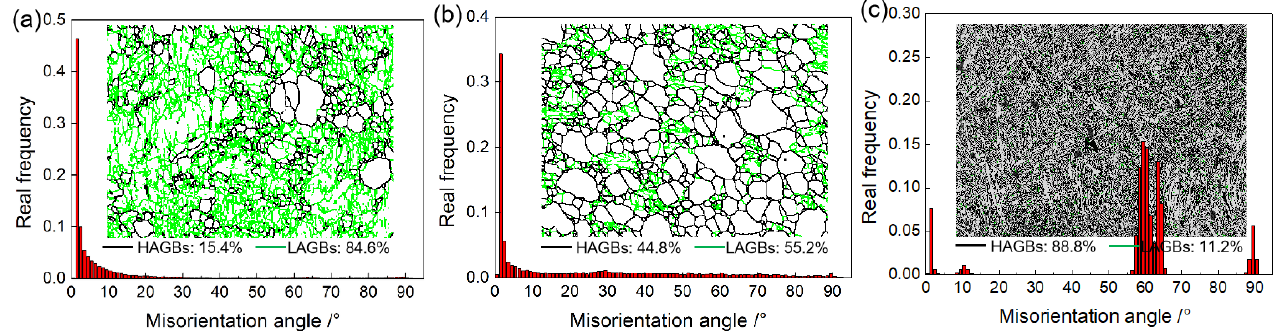
Figure 8. SEM-EBSD misorientation angle distributions of Ti-6Al-4V alloy deformed by 90% at different temperatures: ( a ) 850 °C, ( b ) 950 °C, ( c ) 1100 °C.